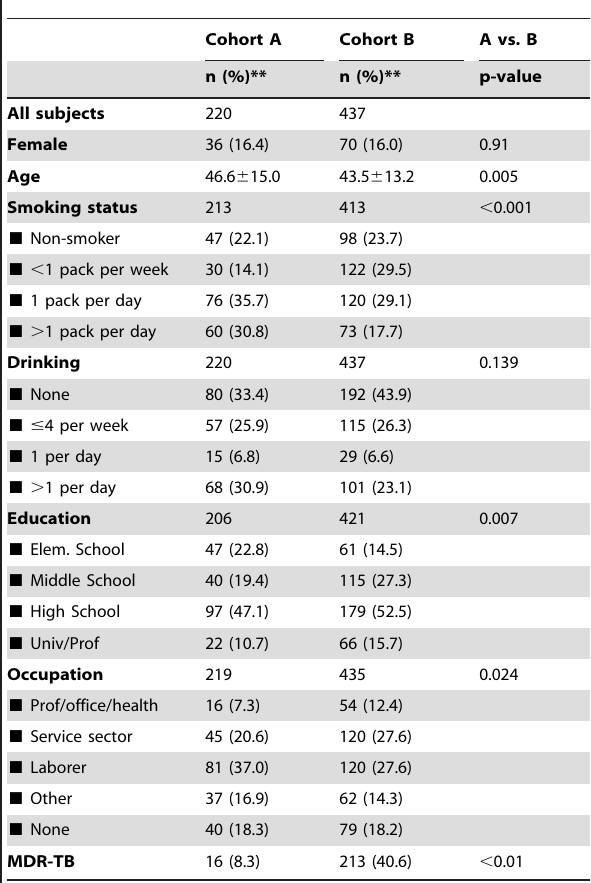
Table 1. Demographic comparison of cohorts.*